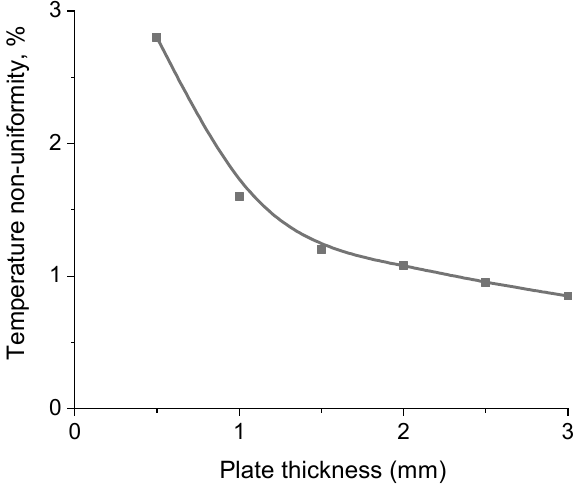
Figure 9. The temperature non-uniformity in the upstream section of the MRHE as a function of plate thickness. First section: counter-current flow. Second section co-current flow. Reactant inlet temperature: 473 K. Reactant flow rate: 2.71 × 10 − 2 m s − 1 . Catalyst layer thickness: 10 µ m. Coolant velocity in each section: 9.0 × 10 − 2 m s − 1 . Coolant inlet temperature: 498 K. The optimised parameters of the MRHE and inlet flow conditions are listed in Table